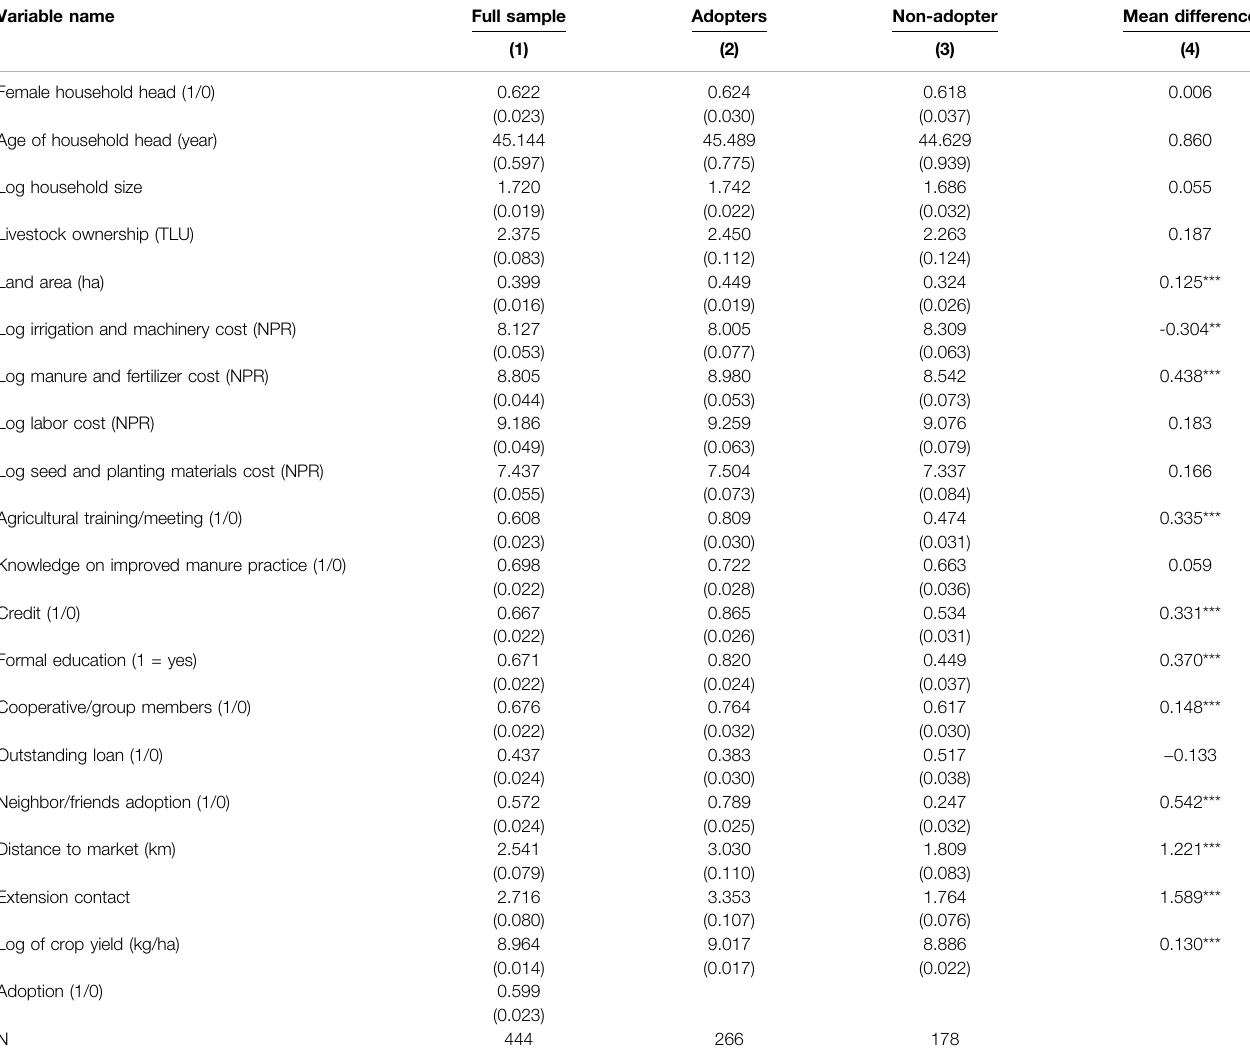
TABLE 1 | Descriptive statistics and mean differences in variables between adopters and non-adopters. Variable